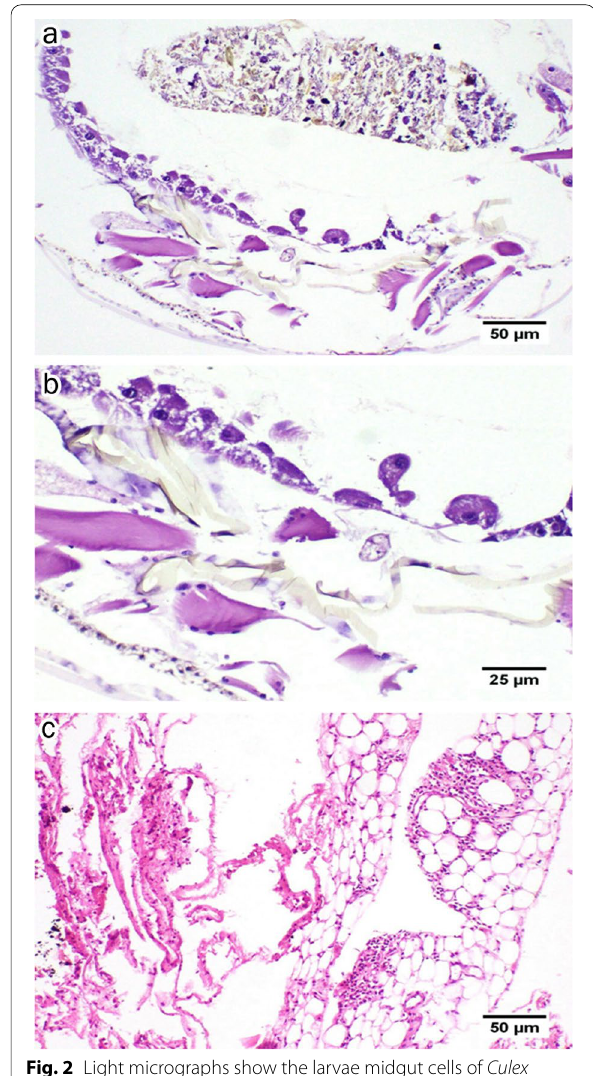
Fig. 2 Light micrographs show the larvae midgut cells of Culex pipiens third instar. a The brush border in the midgut epithelial cells is all completely tight and intact before treatment (control). b 24 h after treatment, notice the protrusion of the brush that surrounds the midgut epithelial cells, with the brush border tending to thin out. c 48 h after treatment, the epithelial cells protrude in the midgut tissues, with the brush boundary totally disordered and thinning